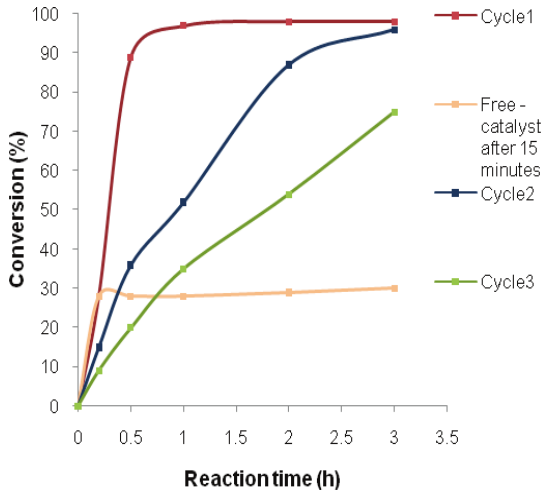
Figure 12. Kinetic curves for three recovery/reutilization cycles and the effect of the SiW leaching for H SiW O /HZSM-5 4 12 40 catalyst ( α -pinene/catalyst ratio of 100/1, at